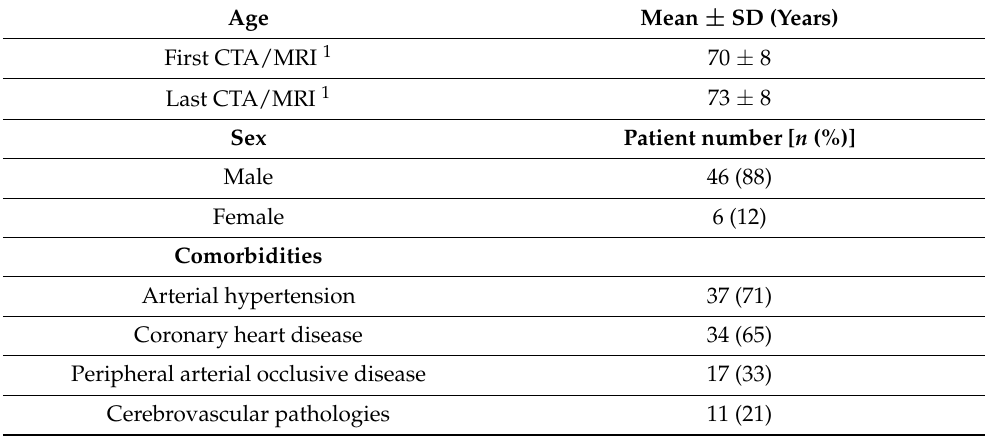
Table 2. Basic patient